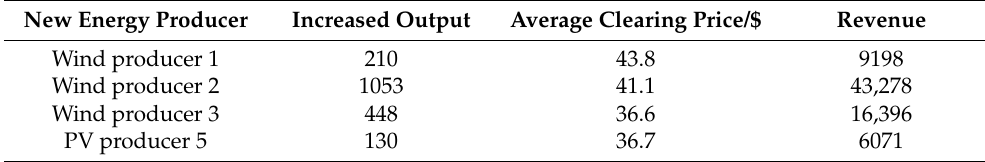
Table 4. Secondary clearing settlement results of renewable energy